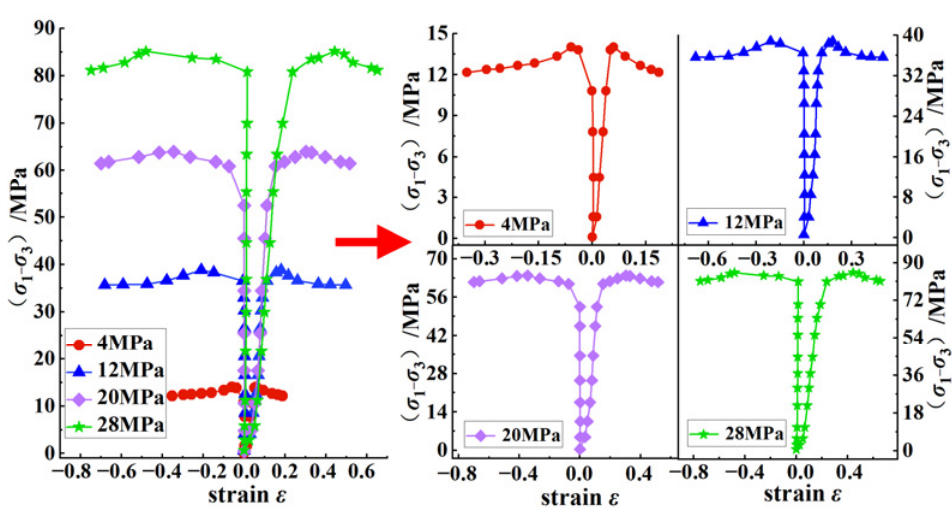
Figure 2. Stress ‐ path diagram. Figure 2. Stress-path diagram.